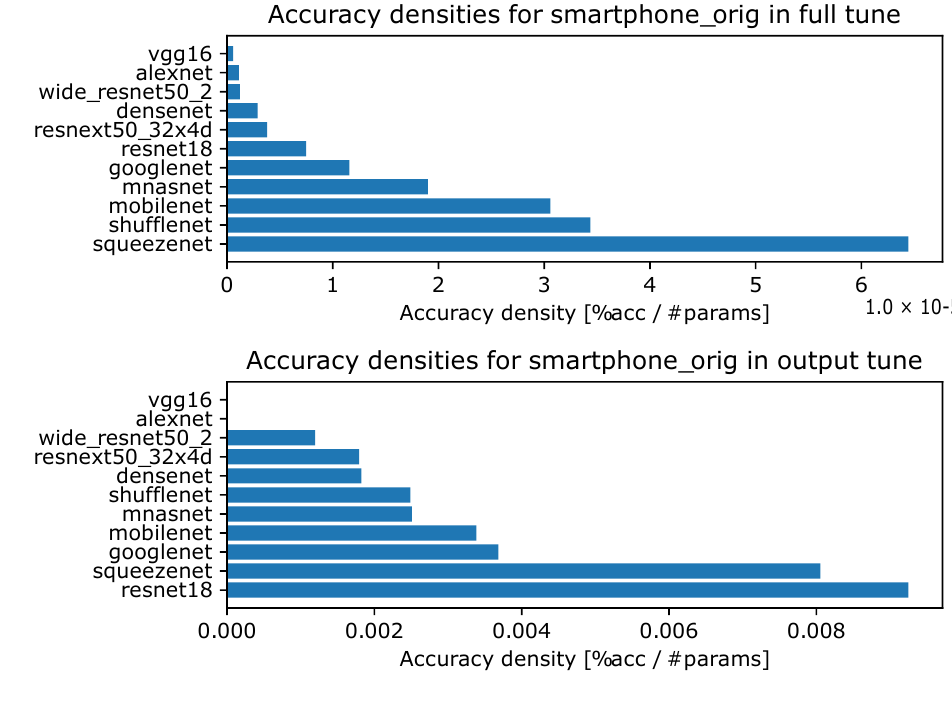
Figure A5. Accuracy densities for one-episode learning on original smartphone data.